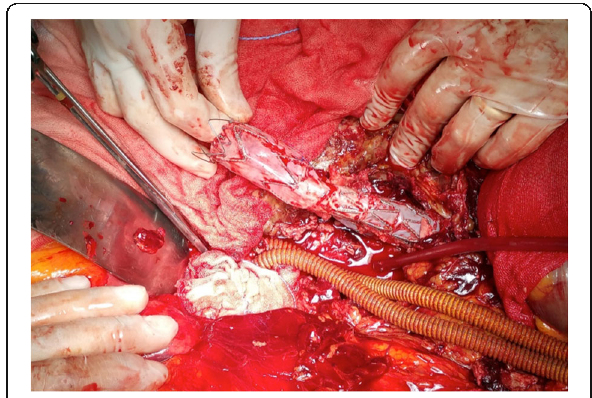
Fig. 2 Proximal part of endovascular grafts removed, and bifurcated silver polyester graft after proximal anastomosis was